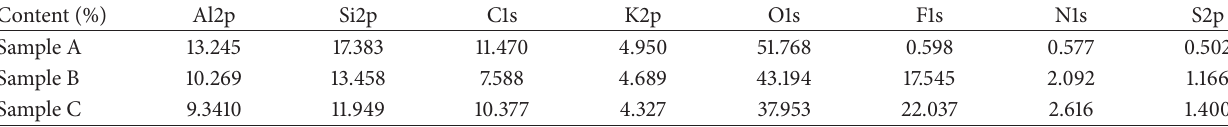
Table 1: XPS element content data of sample systems adsorbing FW-134.